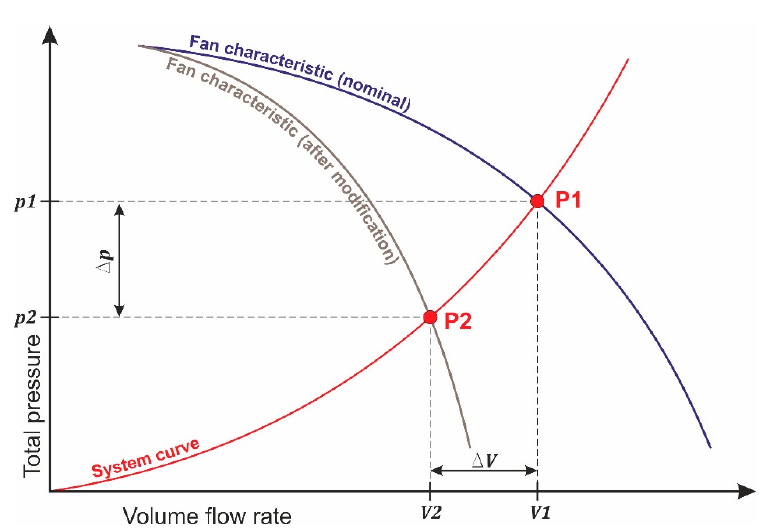
Figure 3. Idea of modulating the fan speed.